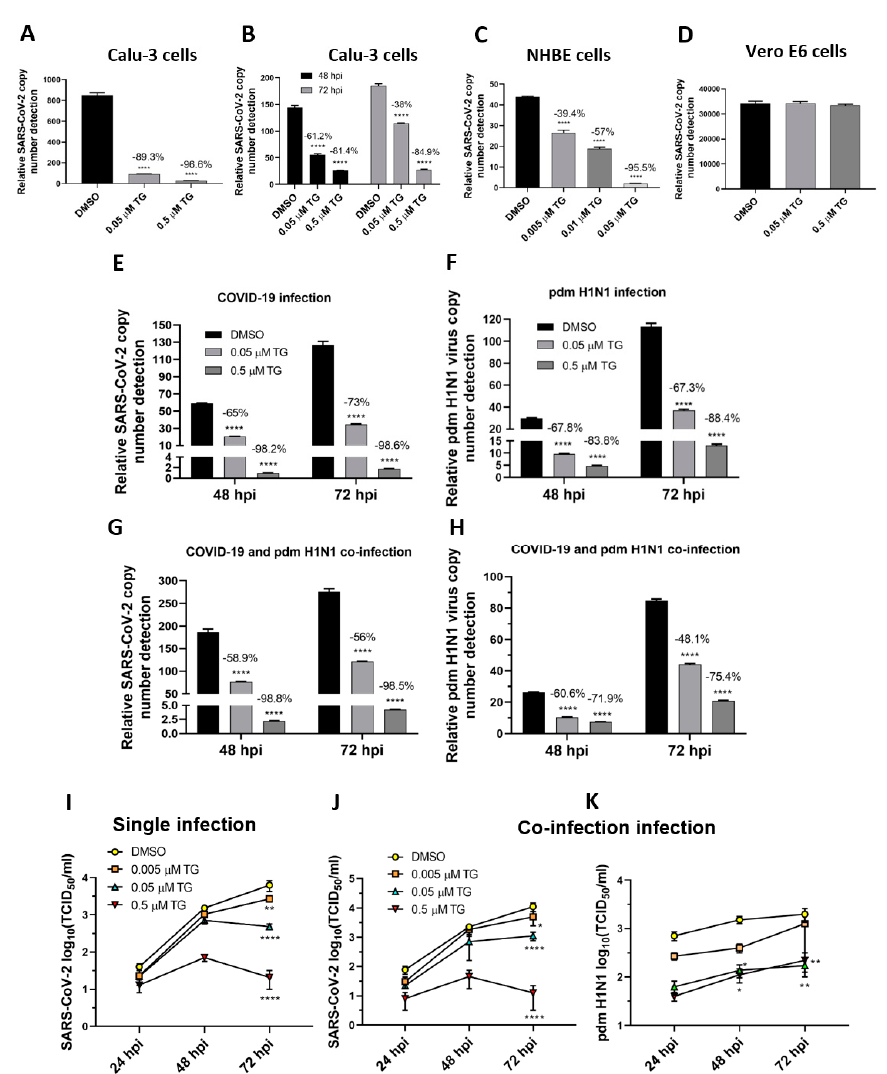
Figure 6. TG effectively blocks progeny SARS-CoV-2 production in single-virus infection and in co-infection with the pdm H1N1 virus. ( A , C , D ) Pre-infection TG priming of Calu-3 and NHBE cells, but not Vero E6 cells, effectively inhibited progeny virus output. Cells were primed with TG as indicated for 30 min, washed twice with PBS and infected with SARS-CoV-2 at 0.01 MOI for 3 h; after which cells were again washed twice with PBS and incubated in serum-free media, supplemented with 0.2 µg/mL TPCK trypsin. Viral RNA extraction was performed on culture media at 72 hpi. ( B ) Priming with TG at 24 hpi blocked replication of SARS-CoV-2 in Calu-3 cells. Cells were first infected with SARS-CoV-2 at 0.01 MOI for 24 h, then primed with the indicated TG for 30 min, washed 3 times with PBS and incubated in serum-free media. Viral RNA extraction was performed on culture media at 48 and 72 hpi. All RNA isolated above were subjected to one- step reverse transcription qPCR to detect the relative copy number of SARS-CoV-2 replicase polyprotein 1ab RNA, based on the relative Ct method. Pre-infection priming of Calu-3 cells with TG inhibited separate infection of ( E ) SARS-CoV-2 and ( F ) the pdm H1N1 virus, and ( G , H ) co-infection with both viruses. Cells were primed with TG or DMSO for 30 min, infected with the corresponding virus at 0.01 MOI for 2 h, washed 3 times with PBS and incubated in serum-free media. At indicated time points post-infection, the media of infected cells were sampled for viral RNA extraction to perform one- step reverse transcription qPCR to detect the relative copy number of SARS-CoV-2 replicase polyprotein 1ab RNA ( E , G ) and influenza M-gene RNA ( F , H ). ( I – K ) Media samples taken at 24, 48 and 72 hpi from similarly infected cultures were used to detect viable progeny virus by TCID 50 virus titration in Vero cells (displayed as mean ± SEM). ( I ) In single-virus infection with SARS-CoV-2, TG exhibited dose-dependent virus inhibition. In co-infection with SARS-CoV-2 and pdm H1N1 virus, TG was just as capable in inhibiting SARS-CoV-2 ( J ) and pdm H1N1 virus ( K ) at the same time. The indicated significance is based on 2-way ANOVA Tukey’s multiple comparisons test and percentage viral RNA change relative to the corresponding DMSO control. * p < 0.05, ** p < 0.01 and **** p < 0.0001.